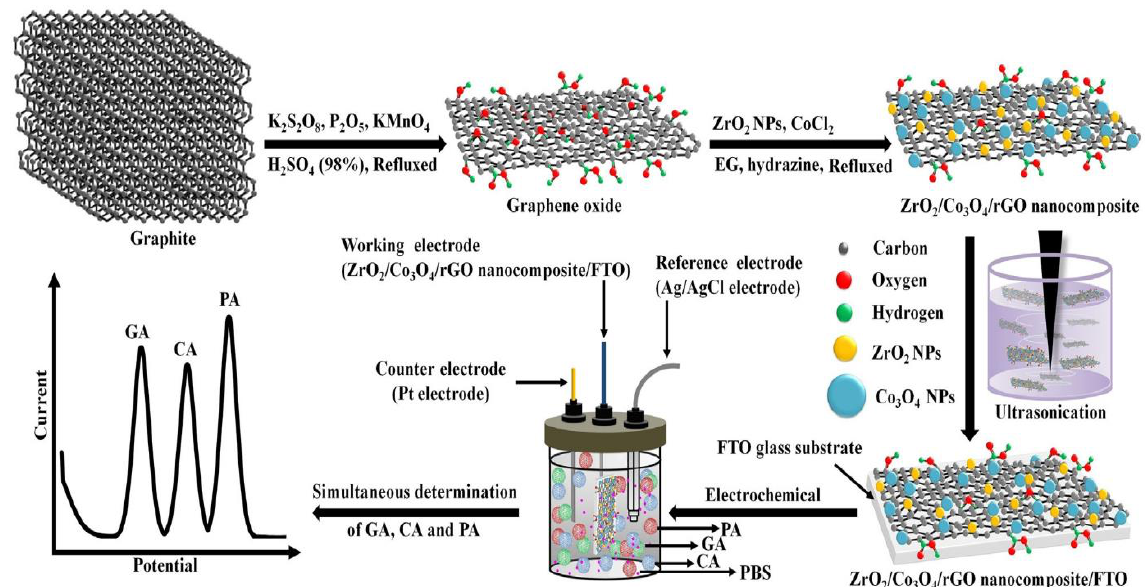
Figure 5. Schematic illustrations of the preparation of ZrO 2 /Co 3 O 4 /rGO nanocomposite and oxidation mechanisms of gallic acid (GA), caffeic acid (CA), and protochatechuic acid (PA). Taken from Puangjan et al. [172].